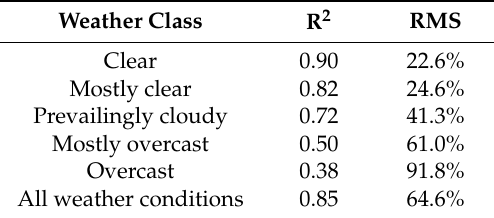
Figure 8. Simulated vs. measured power output of the PV system (red line is to guide your eyes). The RMS error is 64.6% and the R 2 factor 0.85. The errors for each weather class are presented in Table 4. Table 4. Simulation errors with regard to the weather class.